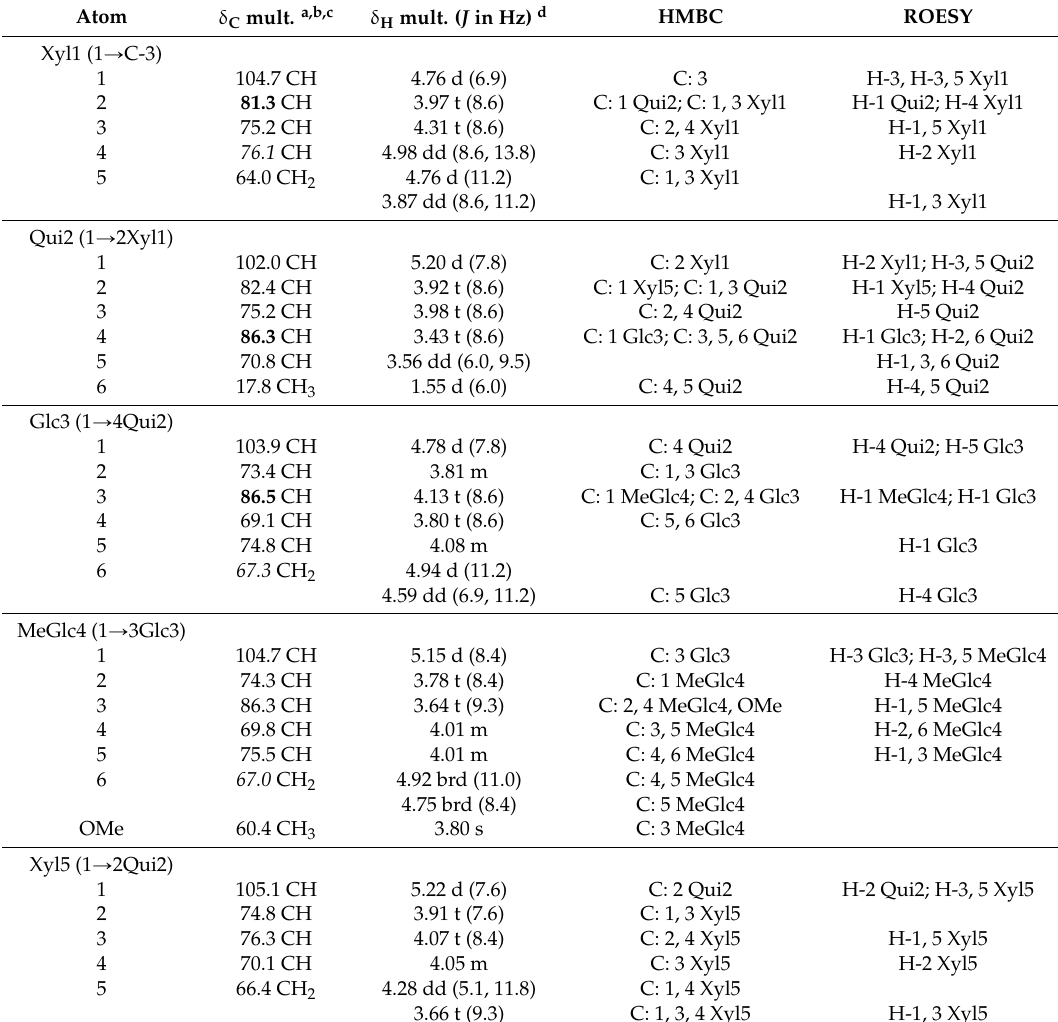
Table 1. NMR Spectroscopic data (700 MHz, C 5 D 5 N/D 2 O (4/1 v / v )) of the carbohydrate moieties of 1 – 4